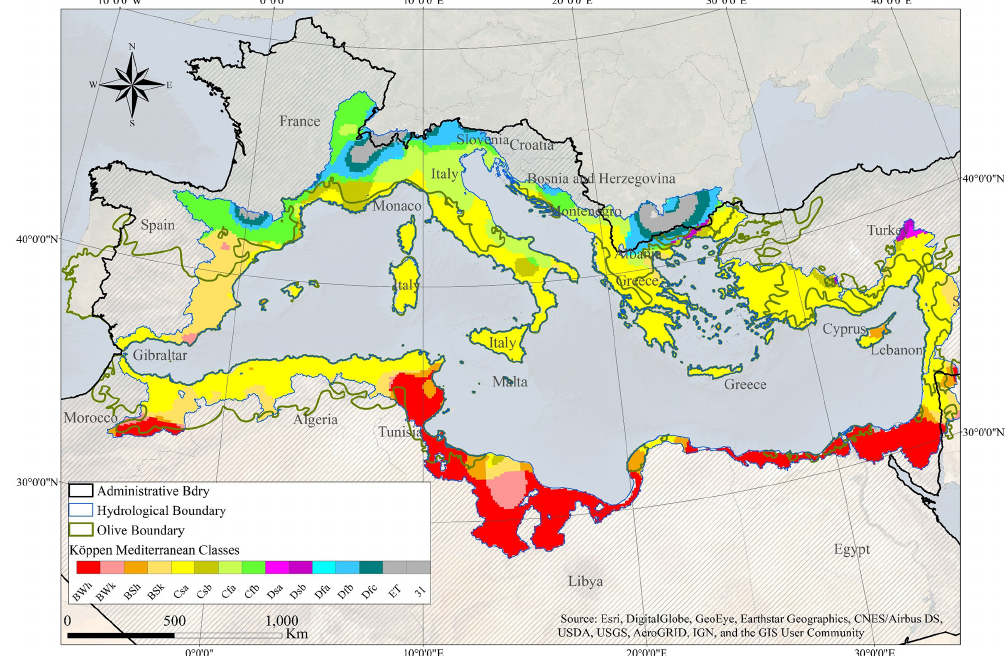
Figure 1. Four Mediterranean region boundaries (Merheb et al., 2016); first administrative, second topographic (Milano, 2013), third olive cultivation (Moreno, 2014), and fourth climatic (Peel et al.,